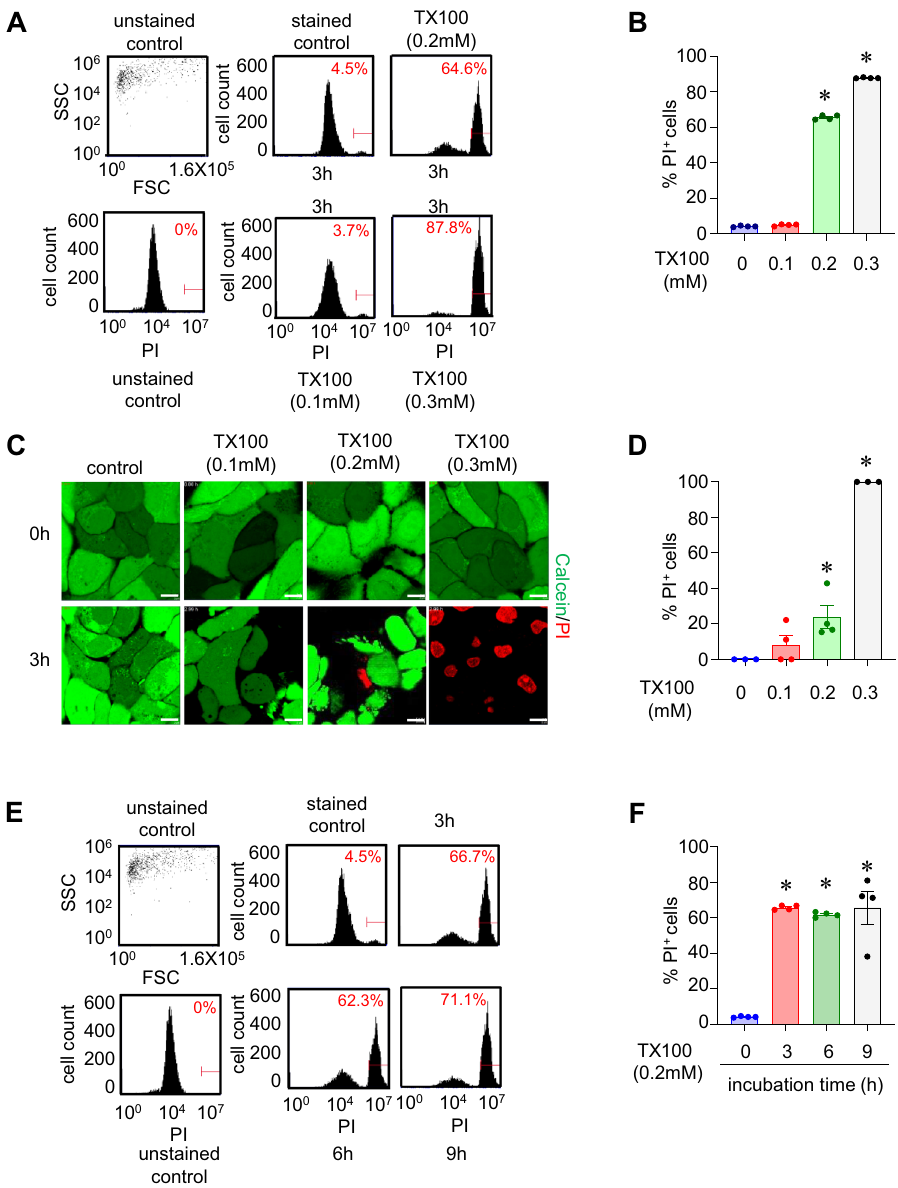
Figure 1. TX100-induced cell death is dose-dependent. Human keratinocytes (HaCaT) were exposed to TX100 at different concentrations and durations. Cells were stained with PI for flow cytometry and Calcein and PI for confocal microscopy. ( A ) Flow cytometry histograms showing %PI-positive cells upon treatment with increasing concentration (0.1 mM, 0.2 mM and 0.3 mM) of TX100 for 3 h. ( B ) Quantification of %PI-positive cells from flow cytometry representing mean ± SEM (n = 4). ( C , D ) Representative confocal images and quantification of %PI-positive cells after 3 h exposure to increasing levels of TX100. Scale, 10 µm. Data represent mean ± SEM (n = 3-4). ( E , F ) Flow cytometry measurements (%PI-positive cells) of HaCaT keratinocytes exposed to TX100 (0.2 mM) for 3, 6, and 9 h. Data represent mean ± SEM (n = 4). * p < 0.05 compared to control